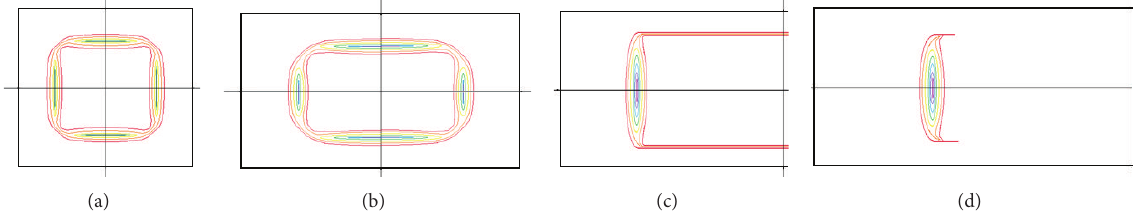
Figure 3: The contour line of particle concentration in varying aspect ratio (AR): (a) AR = 1 , (b) AR = 2 , (c) AR = 3 , and (d) AR = 4 .